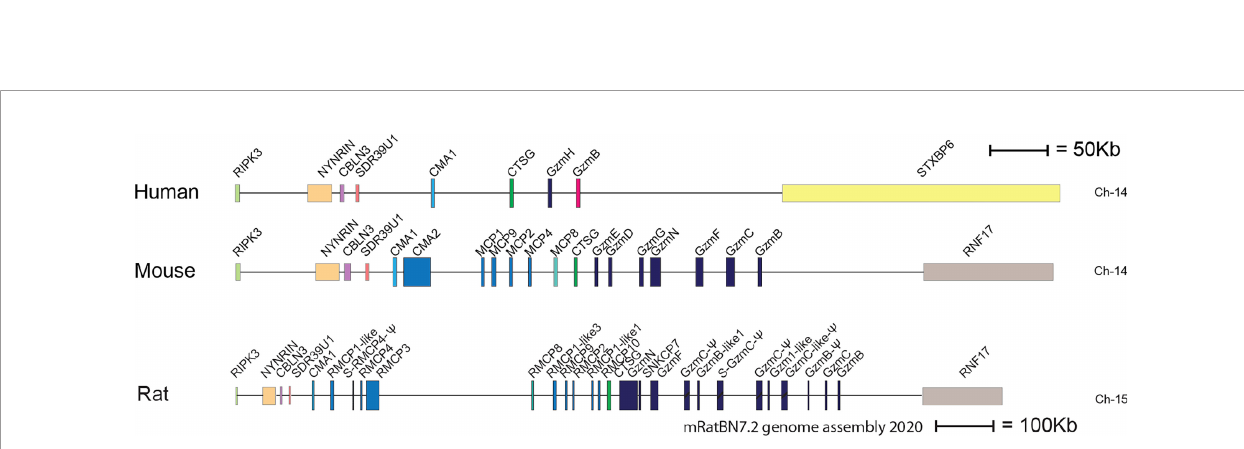
FIGURE 2 | The chymase locus of three mammalian species. An in-scale fi gure of the chymase locus in three mammalian species; human, mouse and rat. The genes are color coded. Granzymes are shown in dark blue, a -chymases in light blue and b -chymases as blue with a darker tint. mMCP-8-related genes are in cyan, duodenases in red and cathepsin G in green. The general scale bar of 50 kB is valid for most of the genes. However, the rat locus is much larger in size why we have reduced the size to half. For rat we have therefore introduced a 100 kB size marker.